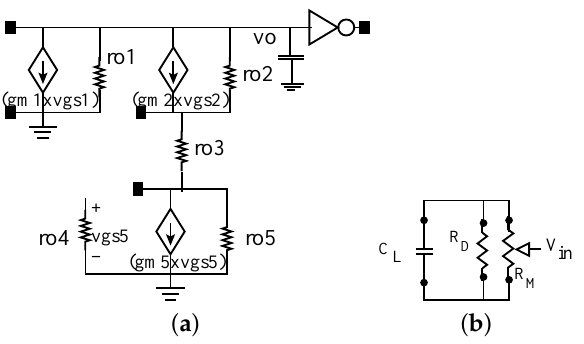
Figure 4. ( a ) Small signal equivalent circuit diagram of the proposed CTC; ( b ) Simplified electrical equivalent diagram of proposed CTC.